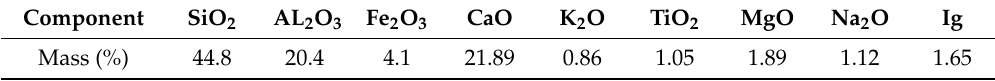
Table 3. The chemical composition of FA.